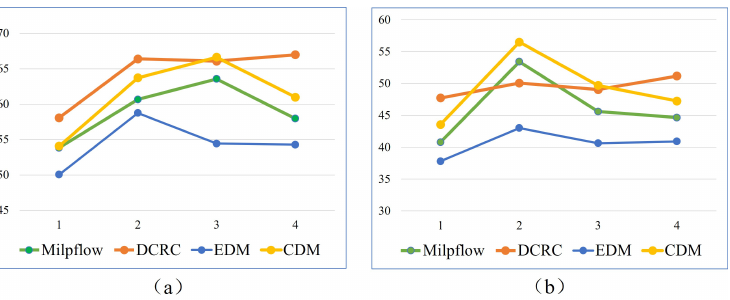
Figure 12. The comparison of coverage times of Milpflow [20], DCRC [3], EDM, and CDM. Fewer coverage times are better. ( a , b ) shows comparison results of two and three robots, respectively.